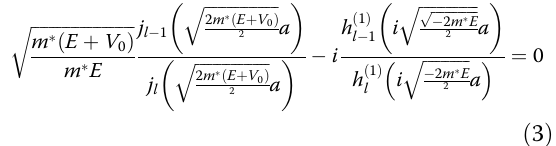
ffiffiffiffiffiffiffiffiffiffiffiffiffiffiffiffiffi 2 m (cid:4) E þ V 0 ð